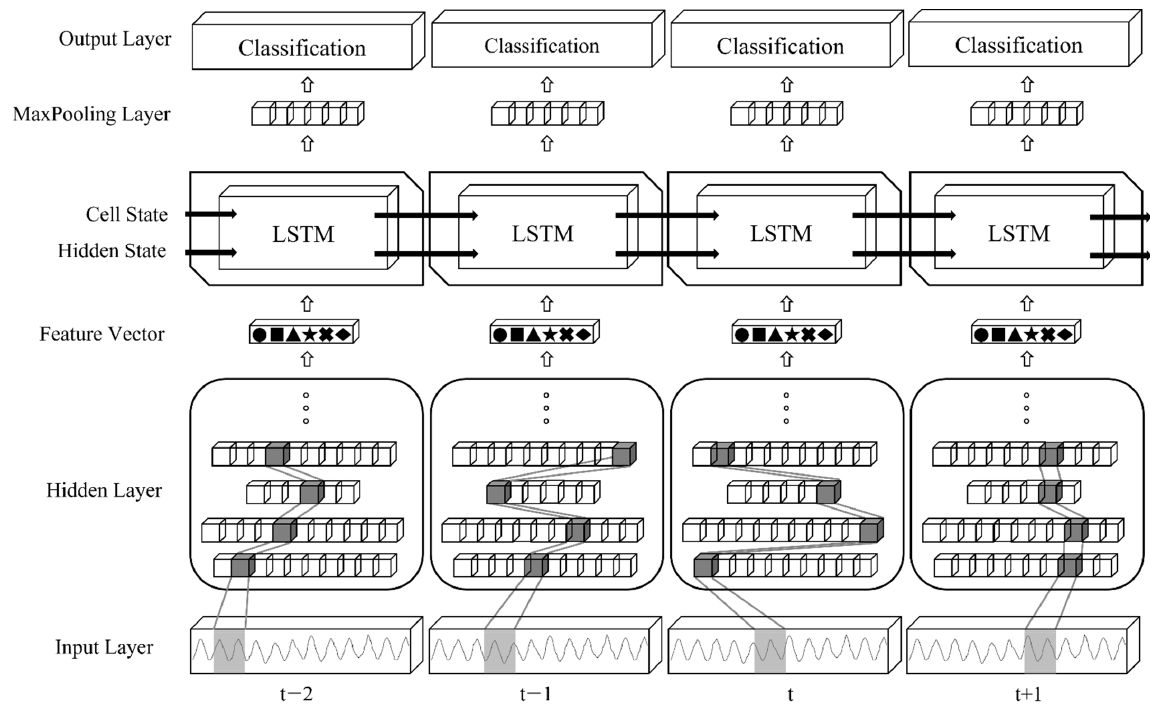
Figure 6. LSTM-C Model.